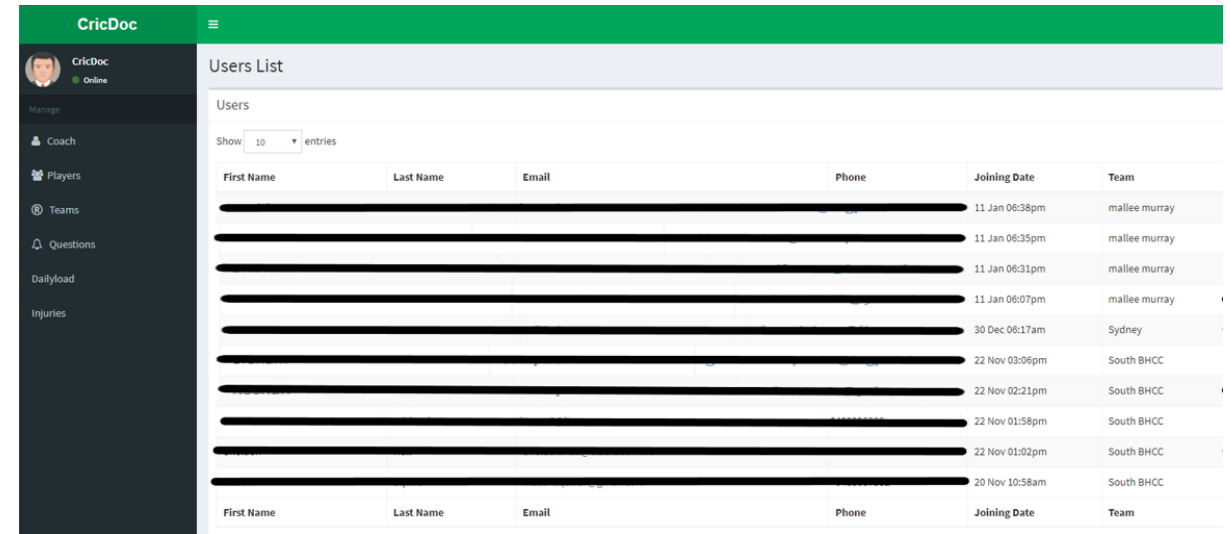
Figure 2. Screenshot from server interface showing data view available to the coaching